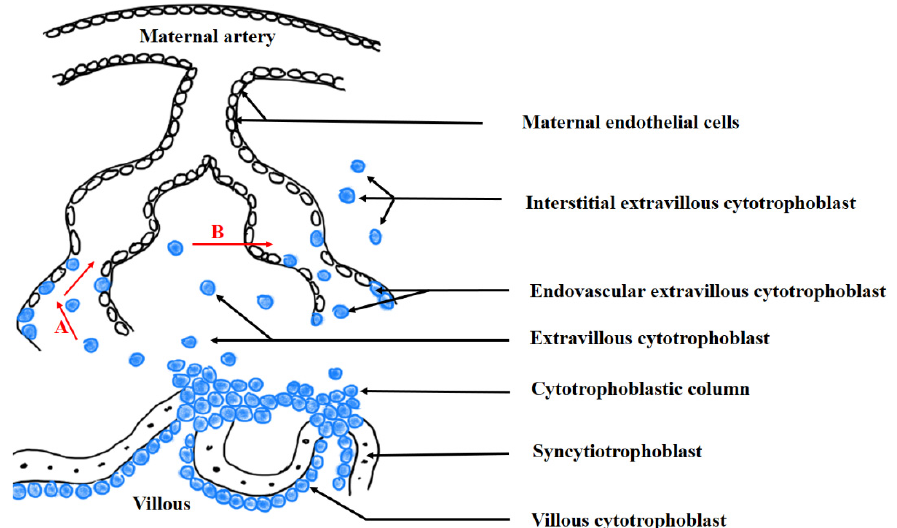
Figure 2. The process of trophoblast invasion into maternal uterine arteries. Red arrows indicate the direction of trophoblast invasion. A—extravasation; B—intravasation. Black arrows indicate the cells participating in the described process. The name of the cells is given on the right side of the black arrow. The blue circles present the cytotrophoblastic cells. The black circles present the maternal endothelial cells.